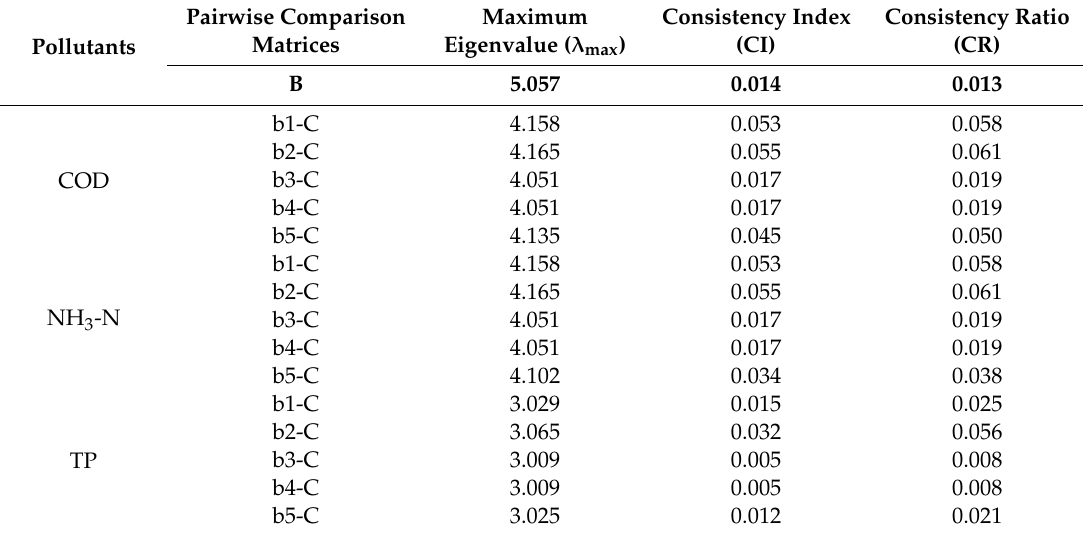
Table 7. The maximum eigenvalues and consistency parameters of the three